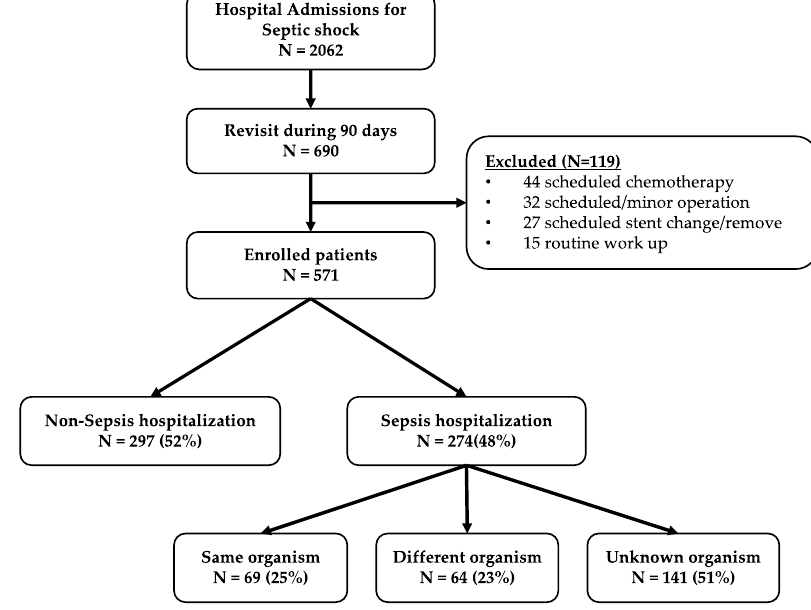
Figure 1. Flowchart of the study population.